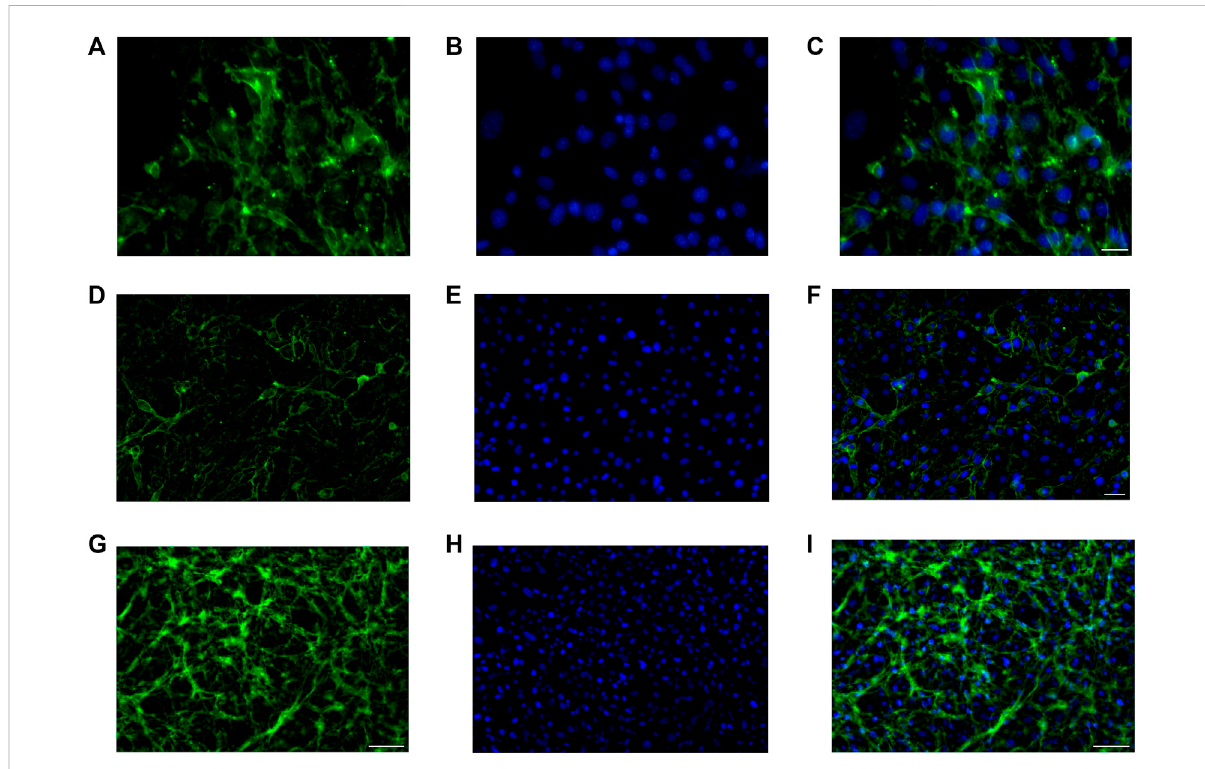
FIGURE 4 Immuno fl uorescence for ZO1, GFP (A – C) , N-cadherin, GFP (D – F) , β -catenin, and GFP (G – I) on bEnd.3 cultured in the LiveBox2 fl uid dynamic bio incubator. Secondary antibody, GFP emission. Nuclei were labeled with Höechst 33258. Scale bars were: 50 µm (C) ; 20 µm (F) ; and 100 µm (I) .